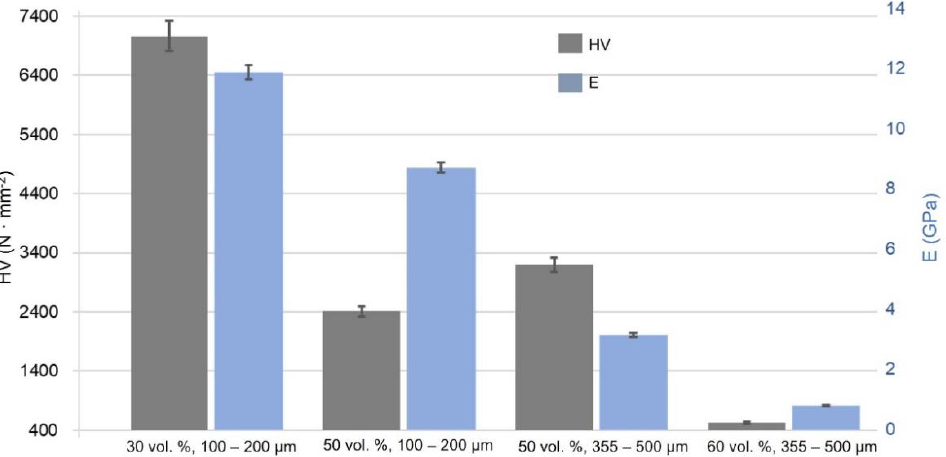
Figure 6. Estimated HV and Young ’ s modulus from the P-h curves.